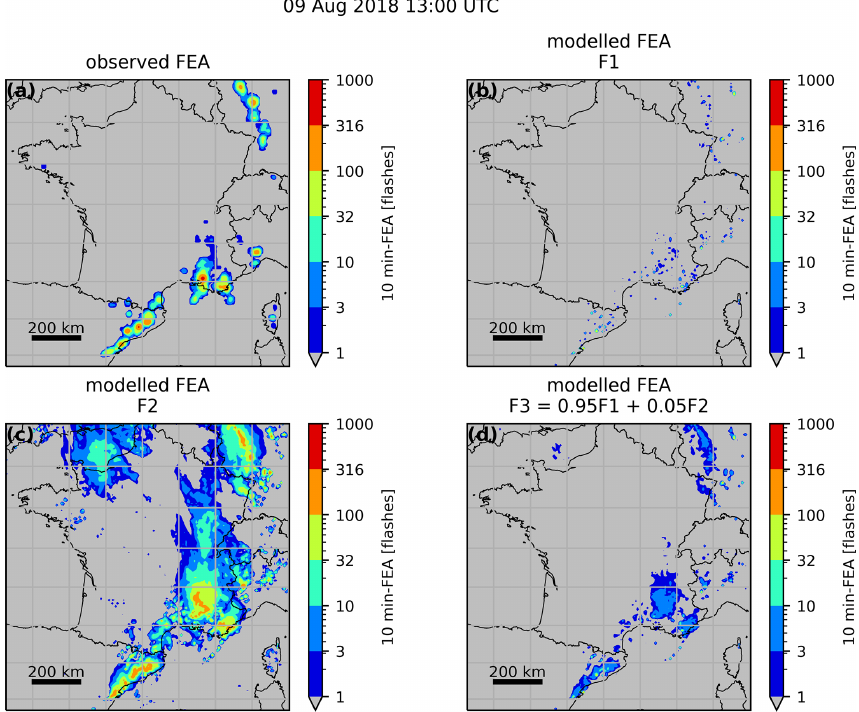
Figure 16. Observed FEA for 9 August 2018 at 13:00UTC (a) and FEA modelled with F1 (b) , F2 (c) and F3 (d)